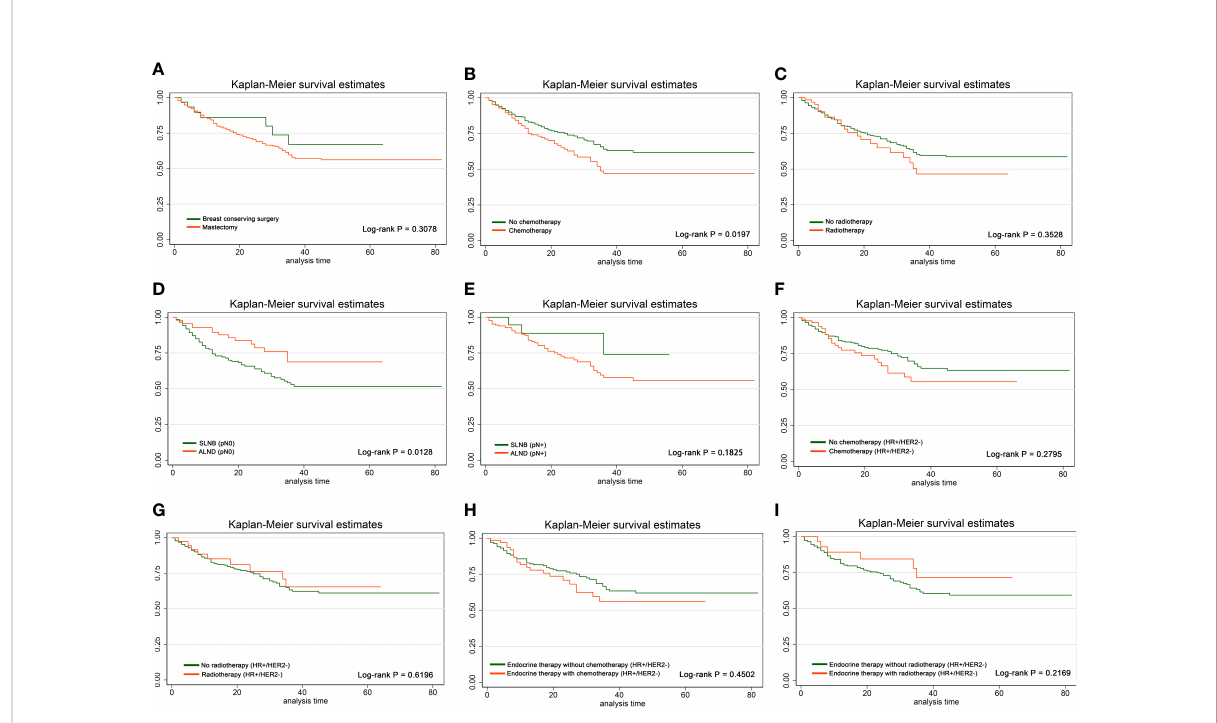
FIGURE 2 Effects of different local and systemic treatments on RFS. Kaplan – Meier curves and log-rank p-values in the comparison between (A) mastectomy group and BCS group, (B) chemotherapy group and non-chemotherapy group, (C) radiotherapy group and non-radiotherapy group, (D) SLNB group and ALND group among pN0 cases, (E) SLNB group and ALND group among pN+ cases, (F) chemotherapy group and non-chemotherapy group among HR+/HER2 − cases, (G) radiotherapy group and non-radiotherapy group among HR+/HER2 − cases, (H) chemotherapy group and non-chemotherapy group among HR+/HER2 − cases who have already received endocrine therapy, and (I) radiotherapy group and non-radiotherapy group among HR+/HER2 − cases who have already received endocrine